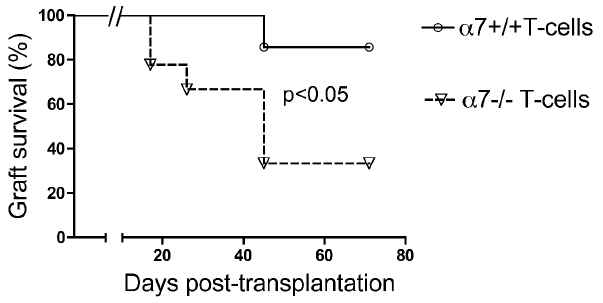
Figure 5. Importance of the a 7nAChR on T cells in imiquimod- induced skin allograft rejection. Lymphopenic female Rag 2 / 2 mice were reconstituted with 8 6 10 6 CD90 + T cells (containing both CD4 + and CD8 + T cells) purified from either a 7 + / + or a 7 2 / 2 female mice. Reconstituted mice were transplanted with a male skin graft harvested from male Rag 2 / 2 mice and imiquimod was applied for days 10 to 15. Skin graft survival in both conditions is shown.